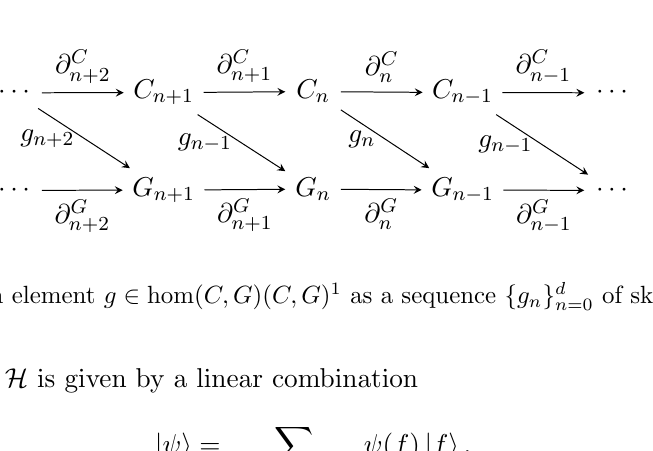
Figure 3 . An element g 2 hom( C; G )( C; G ) 1 as a sequence f g n g d